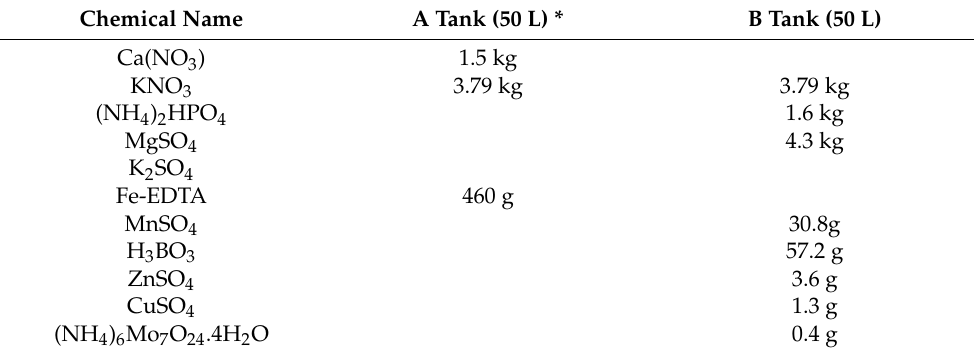
Table 2. Nutrient